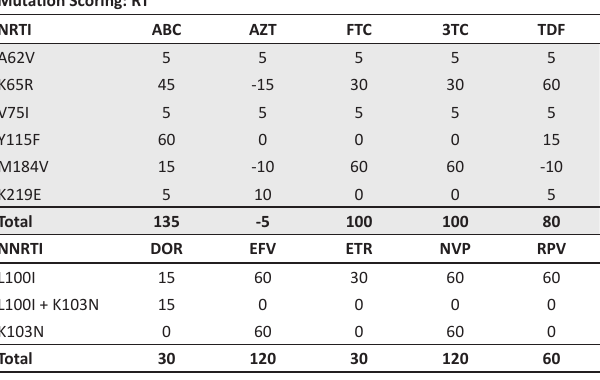
TABLE 2: Mutation-penalty score for the reverse transcriptase inhibitors.